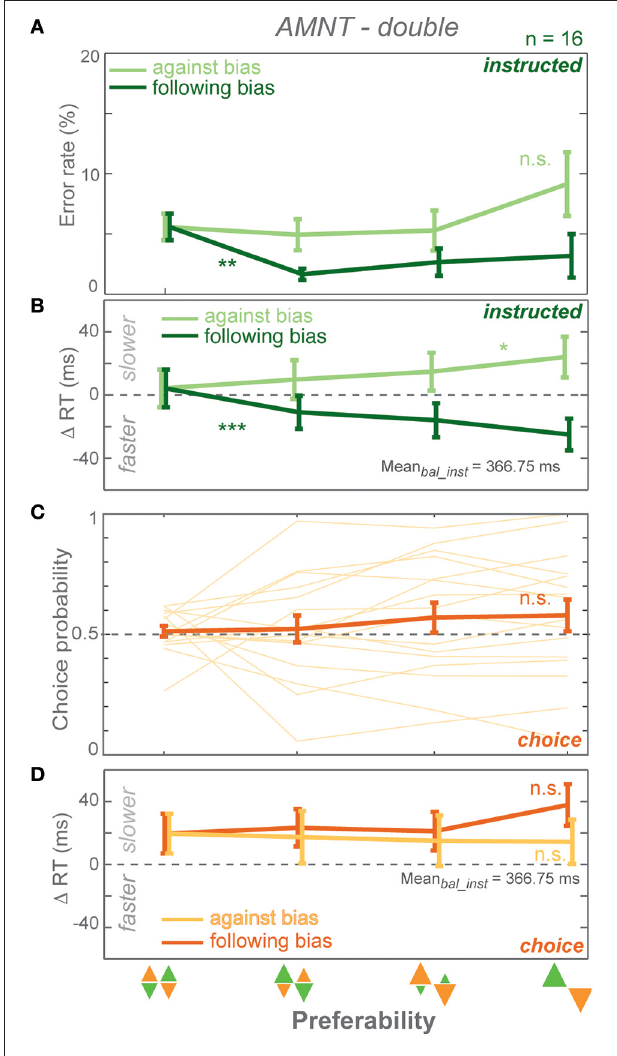
FIGURE 4 | Results of AMNT task with double reward size (AMNT-double). (A) Average error rates, (B) average instructed RT difference, (C) Choice probabilities, (D) average choice RT difference (zero line indicates average RTs in instructed trials of zero-bias condition of each task) in all bias levels. Dark and light colors represent follow and against responses, respectively. Error bars represent standard errors. ( * p < α corr at 5%, ** p < α corr at 1%, *** p < α corr at